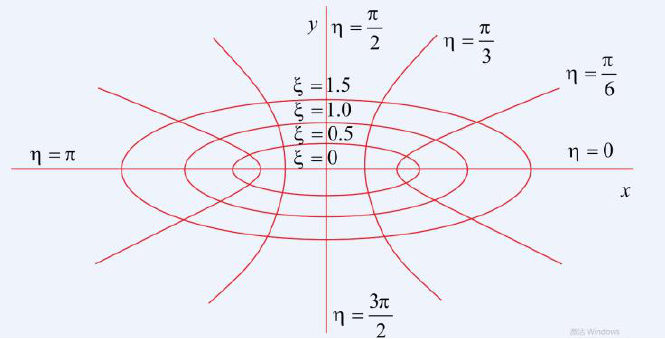
Figure 3. Flow field of the elliptic cylinder with a constant pressure.